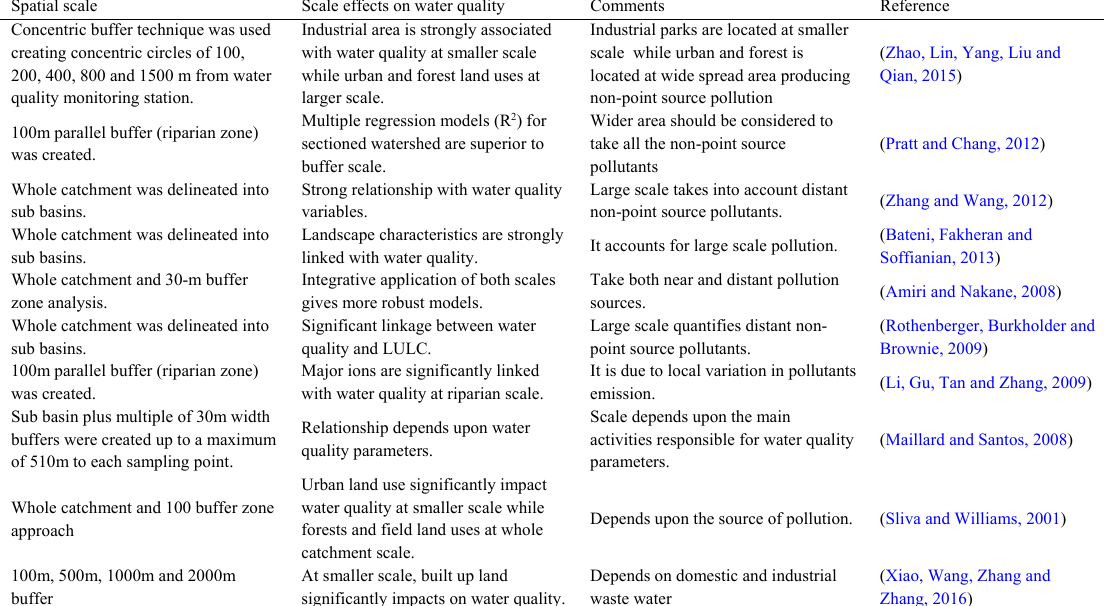
Table 2. Different spatial scale techniques tried to extract land use variables Table 2: Different spatial scale techniques tried to extract land use Scale effects on water quality